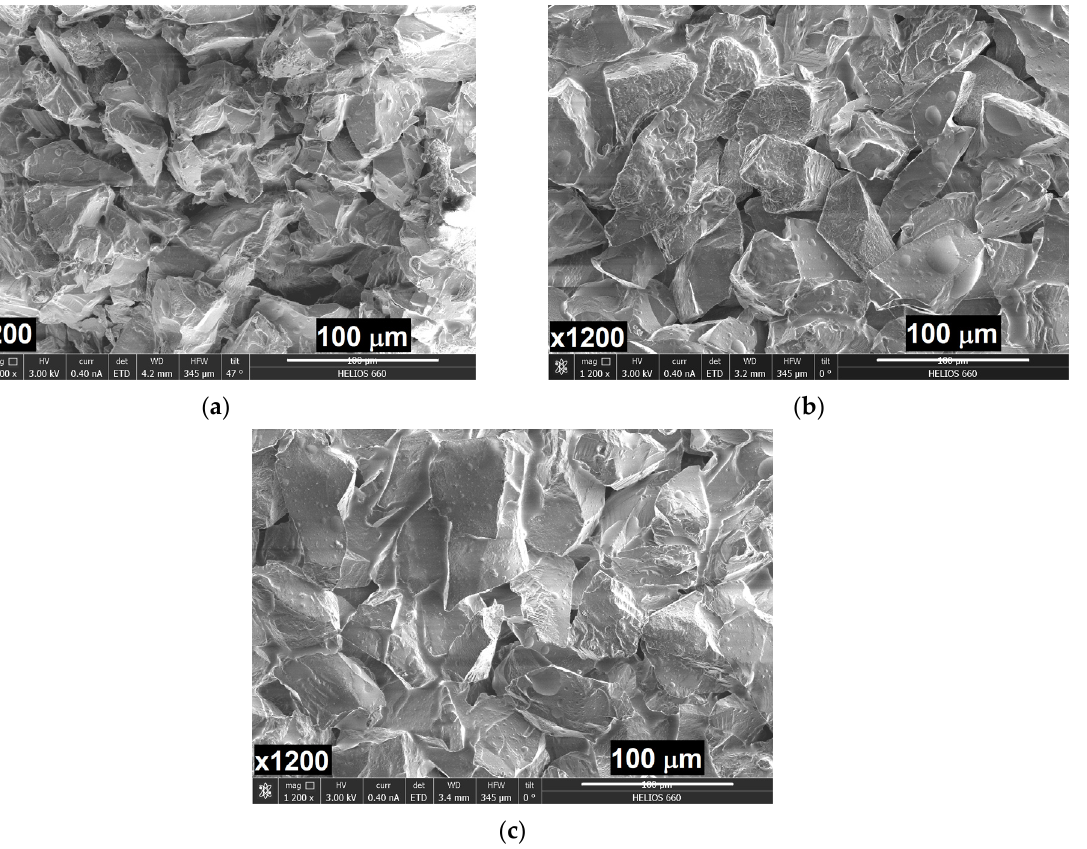
Figure 13. SEM images of fracture surfaces of ceramics based on electrocorundum F240 and obtained by slip casting with ( a ) 5, ( b ) 15, and ( c ) 20 wt.% of bentonite binder. The figures indicated the sintering temperature in °C.